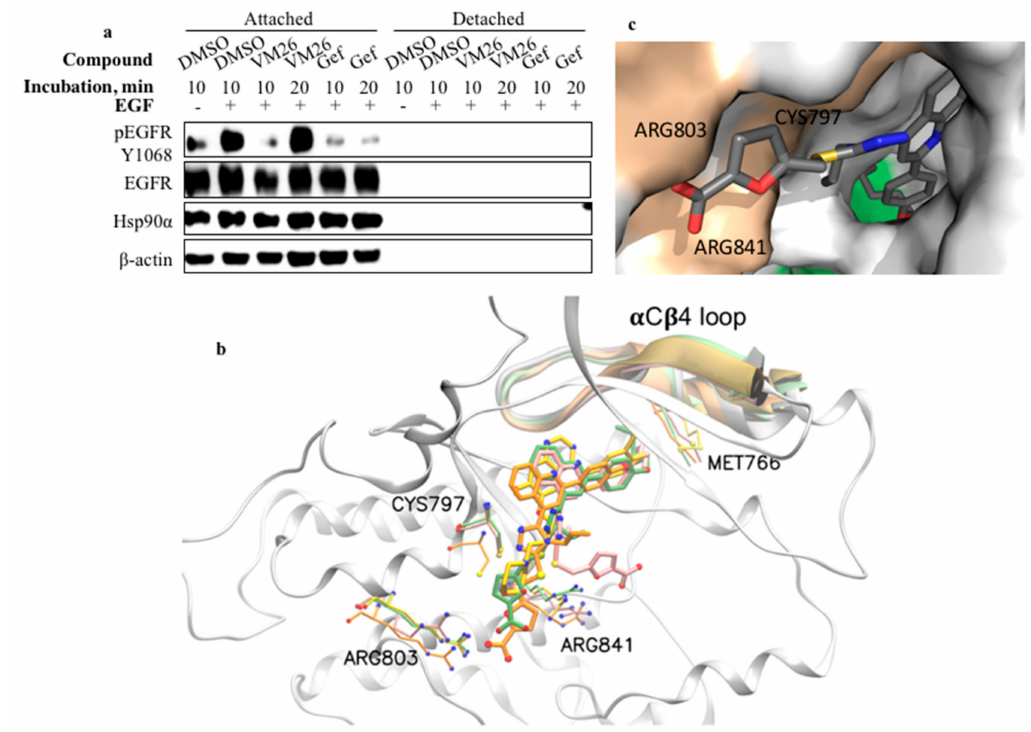
Figure 7. Compound VM26 weakly suppresses EGFR phosphorylation. ( a ) EGFR expression and tyrosine phosphorylation at Tyr1068 were evaluated in MDA-MB-468 cells after exposure to 25 µ M VM26 or gefitinib (Gef) for 10 min and 20 min. The cells were stimulated with EGF (200 ng / mL) for 5 min. Modeling of interactions between representative small compounds and the EGFR catalytic domain. ( b ) A 3D view of the superposition of EGFR bound to VM23 (orange), VM25 (pink), and VM26 (green) and gefitinib (yellow). Nitrogen, oxygen, and sulfur atoms are represented as blue, red and yellow spheres, respectively. The α C β 4 loop containing Met766 corresponds to the region between 761 and 781 amino acid positions. ( c ) Close-up view of the compound VM26 accommodation in the hydrophobic cavity (green) in the tyrosine kinase domain. The amino acids Met766, Phe856, Leu788 and Leu858 form the cavity, and Cys797, Arg803, and Arg841 are located in the catalytic pocket (salmond) (see also Supplementary Figure